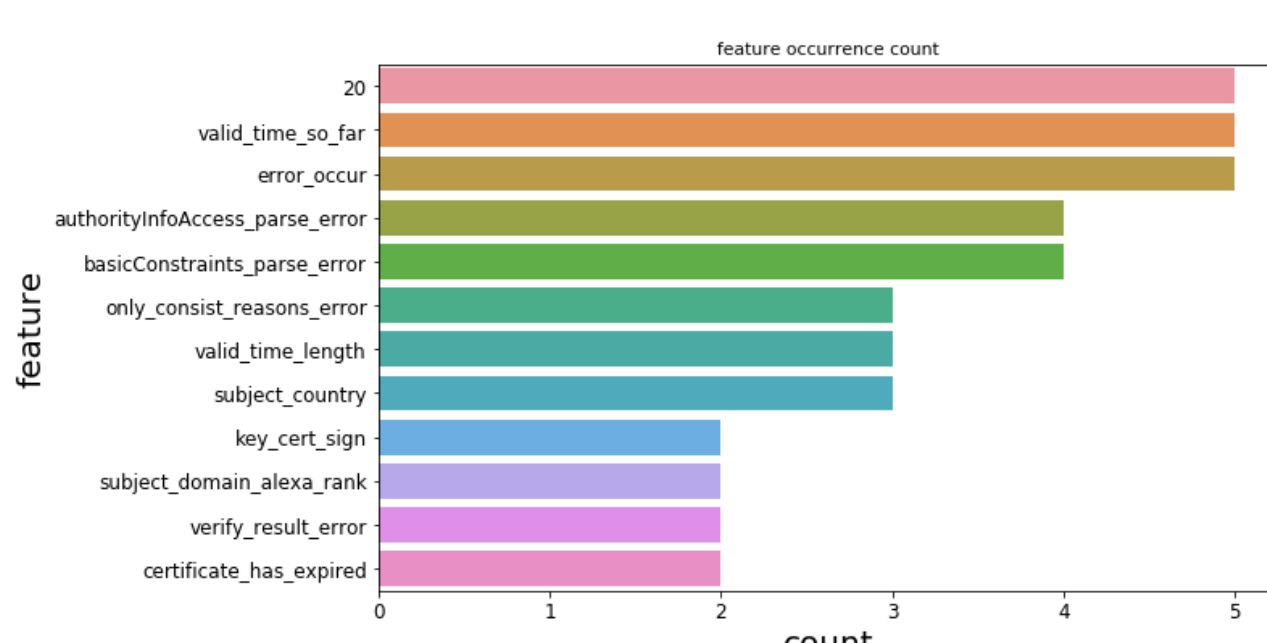
Figure 9. Important features of Random Forest (RF).